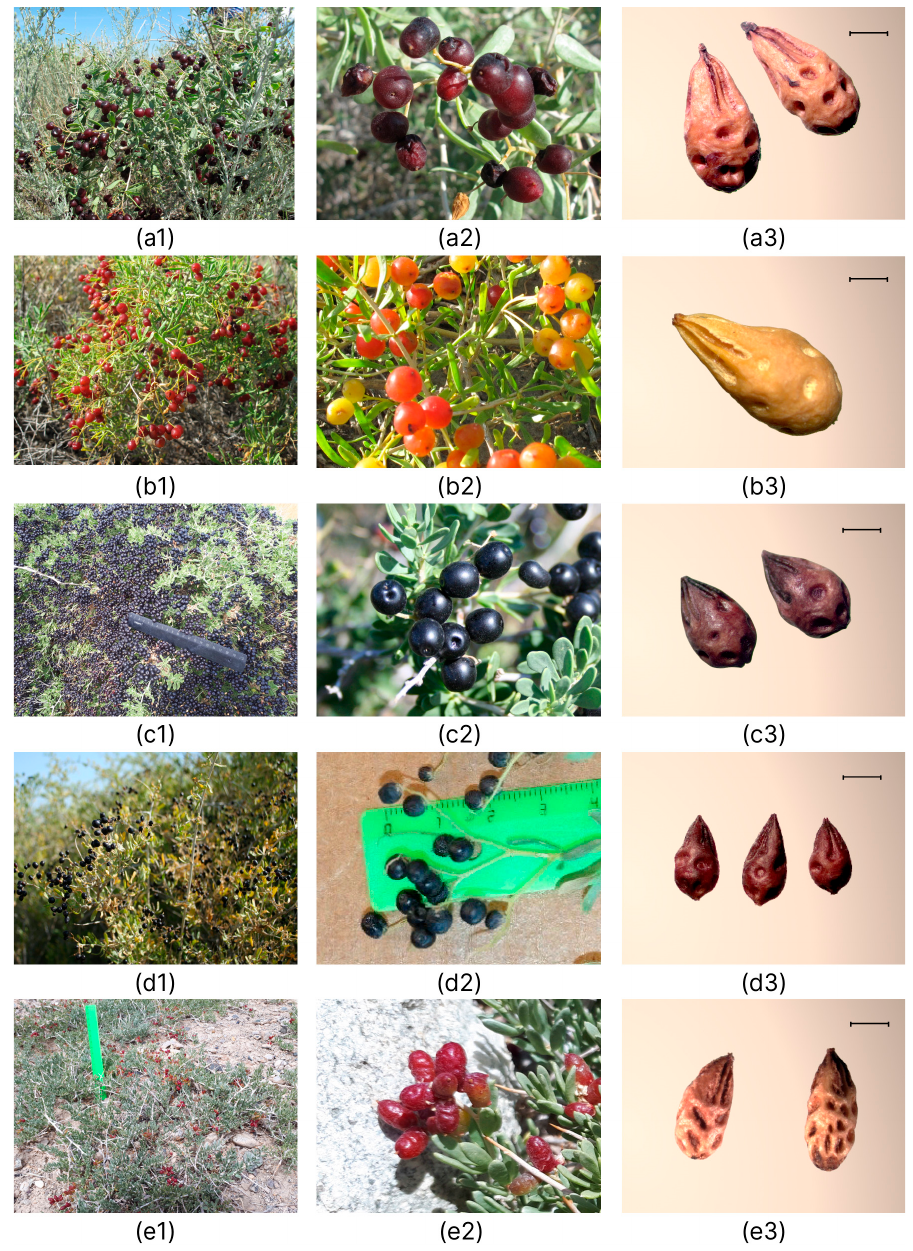
Figure 9. Morphological differences amongst ( a1 – a3 ) N. schoberi , ( b1 – b3 ) N. komarovii , ( c1 – c3 ) N. sibirica , ( d1 – d3 ) N. iliensis and ( e1 – e3 ) N. pamirica at fruiting stage, 1—habit, 2—fruit, 3—stone. Photo by Banaev E.V.